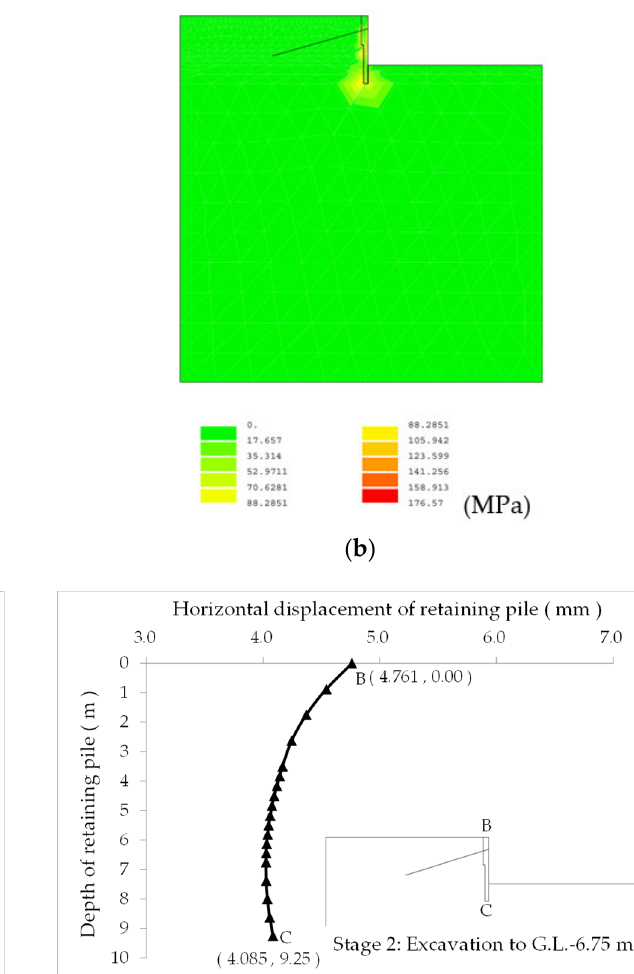
( d ) Figure 8. Results obtained with the 2D FEM analysis of the first ‐ stage excavation: ( a ) iso ‐ value of the total displacement; ( b ) iso ‐ value of the second deviatoric stress; ( c ) vertical surface displacement along the AB line; ( d ) horizontal displacement of the retaining pile along the BC line. Similarly, after continuing the calculation of the second ‐ stage excavation, the displacement changes in the railway track surface and the surrounding ground surface, as well as the deviatoric stress at the bottom of the vertical walls and the retaining pile,